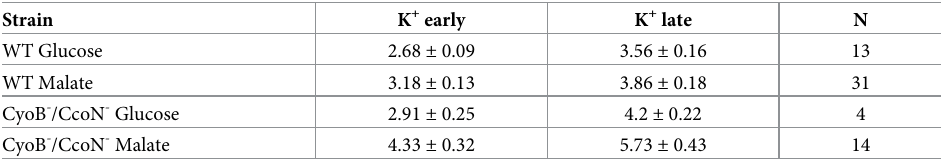
CyoB - /CcoN - Malate Mean ± SE of the fold increase in respiration rate immediately after addition of KCl to a final concentration of 10 mM (K + early) or several minutes later just before oxygen was largely depleted (K + late) with respect to the rate observed with substrate before addition of